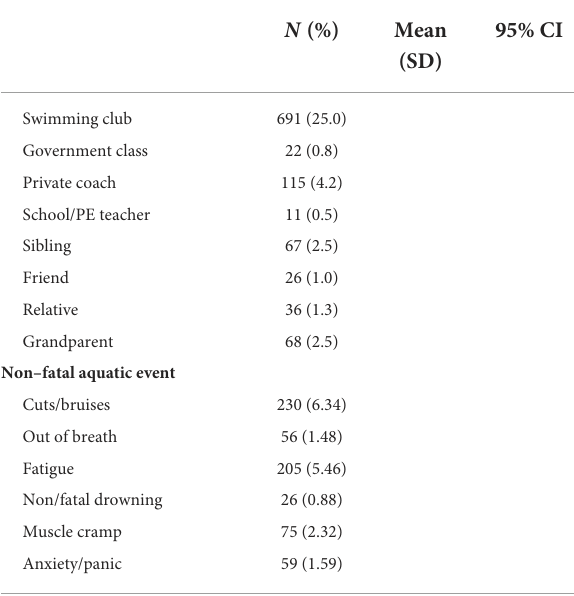
TABLE 1A Descriptive characteristics of the